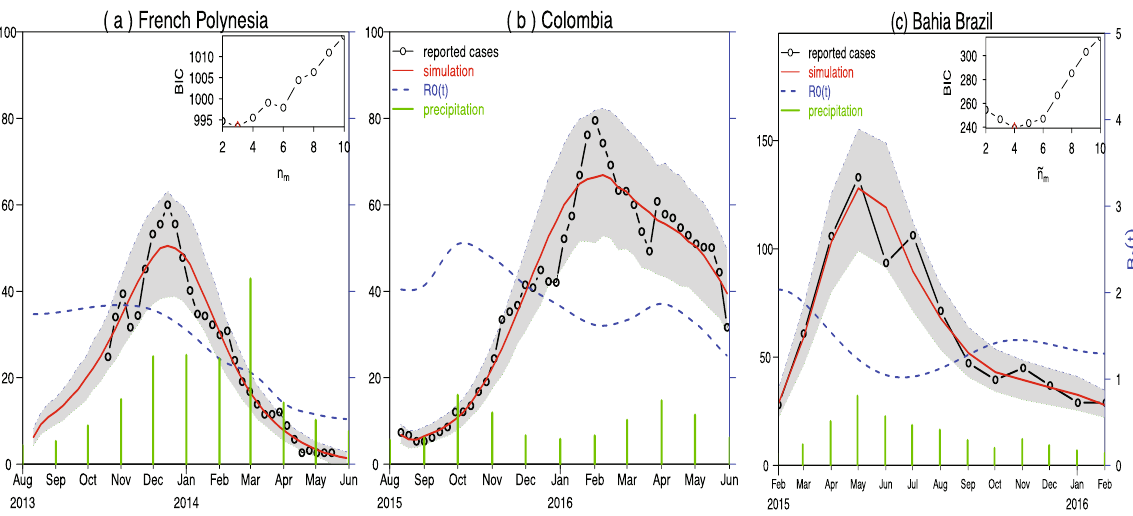
Figure 2. Fitting model to ZIKV cases in ( a ) French Polynesia in 2013–14; ( b ) Colombia in 2015–16; and ( c ) the State of Bahia in Brazil in 2015–2016. Black circle curves represent observed cases, red curves indicate the medians of 1000 simulations with estimated parameters, the shaded regions are the 95% ranges, and blue dashed curves show the estimated reproduction numbers. The insert shows the profile Bayesian Information Criterion (BIC) as a function of the number of nodes in the mosquito abundance.